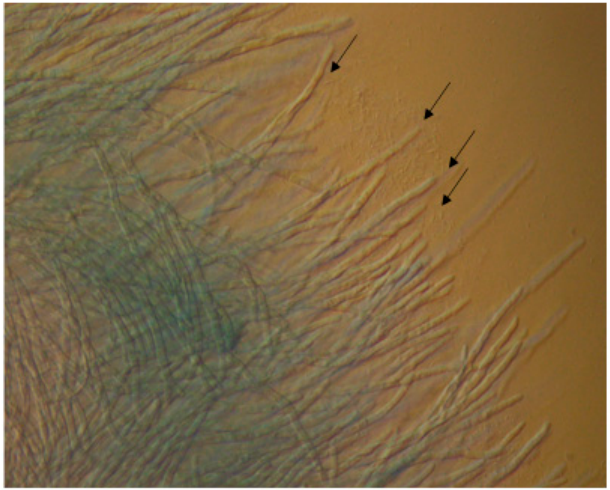
Figure 2. P. aeruginosa cells (indicated with black arrows) travel toward A. fumigatus mycelia and cluster around the hyphal tips. Viewed through an Olympus BX61 fluorescent microscope (40X). While the relationship between P. aeruginosa – A. fumigatus is antagonistic for the most part, there is increasing evidence to show that P. aeruginosa volatile organic compounds (VOC) stimulate the growth of A. fumigatus without the requirement for direct contact between the pathogens [101,124]. Volatile sulfur compounds (VSC) such as di- methyl sulfide (DMS) released by P. aeruginosa provide A. fumigatus with a sulfur source, which is necessary for fungal growth [124]. In the CF airways, P. aeruginosa releases VOCs [125], thus the VOC-mediated stimulation of fungal growth may facilitate the per- sistence of A. fumigatus in the lungs. 6. Interactions Between A. fumigatus and Other Pulmonary Pathogens With the exception of P. aeruginosa , the interactions between A. fumigatus and other pulmonary pathogens remain relatively unexplored, although this is changing as the recognition for the impact of polymicrobial interactions involving this pathogen on dis- ease progression begin to surface [6]. A better understanding of these dynamics may help predict the treatment regimens necessary to ameliorate pulmonary infections. While bacteria such as S. aureus are associated with chronic colonization in juvenile CF patients, A. fumigatus persists throughout the lifetime of individuals with CF, but rarely establishes chronic infection [64,126,127]. Co-cultures of S. aureus and A. fumigatus conidia revealed antagonistic interactions resulting in the bacteria outcompeting the fungus [18]. In this study, S. aureus cells adhered to conidia and fungal-bound bacteria served as a chemoattractant for other bacterial cells. Fungal inhibition by S. aureus was most effective where bacteria adhered to the surface first. Bacteria induced lysis of the conidia and interfered with hyphal development [18]. The Gram-positive bacterium, Streptococcus pneumoniae , is the causative agent of pneumonia and sepsis in elderly people and children [128–130]. These bacteria are also detected in the airways of CF patients and associated with pulmonary exacerbations, particularly in children [131–133]. S. pneumoniae inhibit the development of A. fumigatus in vitro, and disassemble pre-formed fungal biofilm, the mechanism for which is regu- lated by pneumolysin and hydrogen peroxide, which bacteria produce as a byproduct of aerobic respiration [134]. Although Klebsiella pneumoniae is not typically associated with CF infections, it is nonetheless a common cause of pulmonary disease [135,136]. In vitro, in mixed biofilms, K. pneumoniae suppressed A. fumigatus conidial germination, hyphal development, and